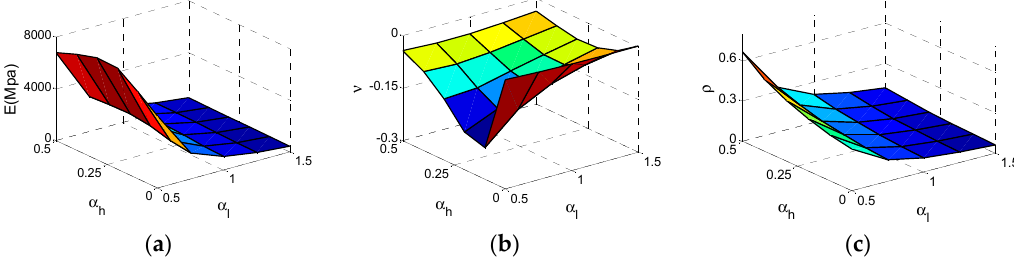
Figure 14. The Surfaces of effective properties for Type D cell: ( a ) effective Young’s modulus E ; ( b ) effective Poisson ratio v ; ( c ) relative density ρ .